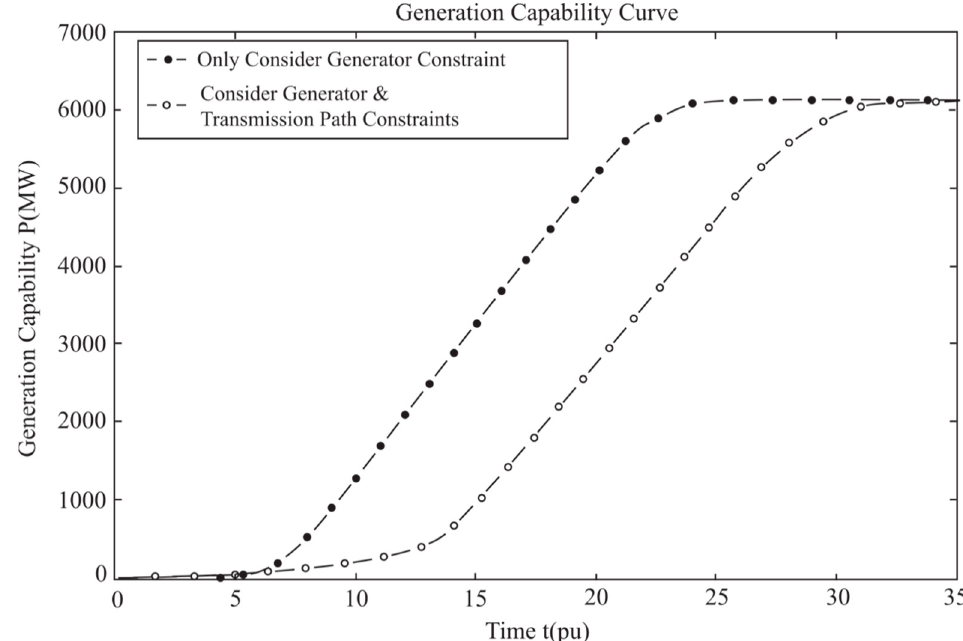
Figure 2. Generation capability curve. Graphic depictions of this kind ease the comparison of the effectiveness of different restoration schemes.